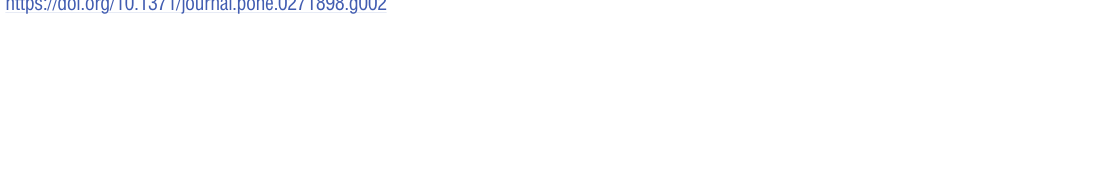
PLOS ONE | https://doi.org/10.1371/journal.pone.0271898 August 4,